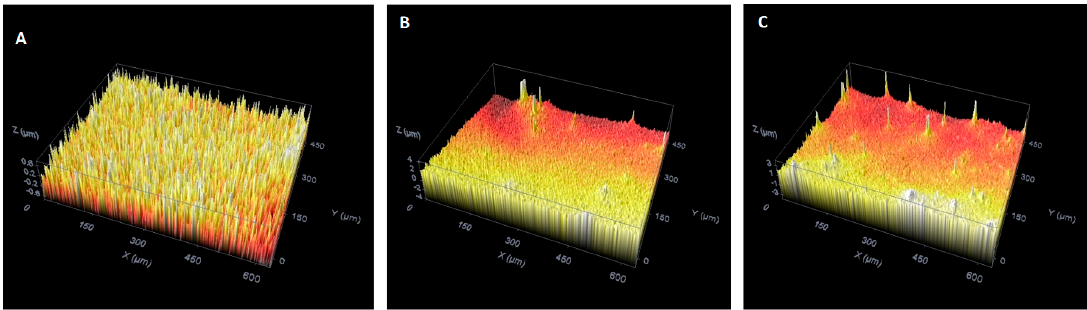
Table 4. Surface roughness parameters for uncoated Ti6Al4V alloy and HAp coated Ti6Al4V alloy Figure 7. Confocal microscope three-dimensional images of the uncoated Ti6Al4V surface ( A ) and Figure 7. Confocal microscope three-dimensional images of the uncoated Ti6Al4V surface ( A ) and thermally treated at 600 °C/2 h and 800 °C/2 HAp coatings on Ti6Al4V thermally treated at 600 °C/2 h ( B ) and 800 °C/2 h ( C ), repectively HAp coatings on Ti6Al4V thermally treated at 600 ◦ C/2 h ( B ) and 800 ◦ C/2 h ( C ), repectively